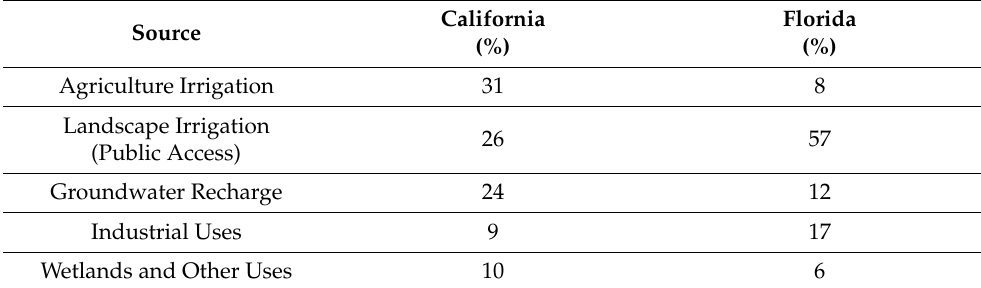
Table 2. Wastewater reuse in California and Florida